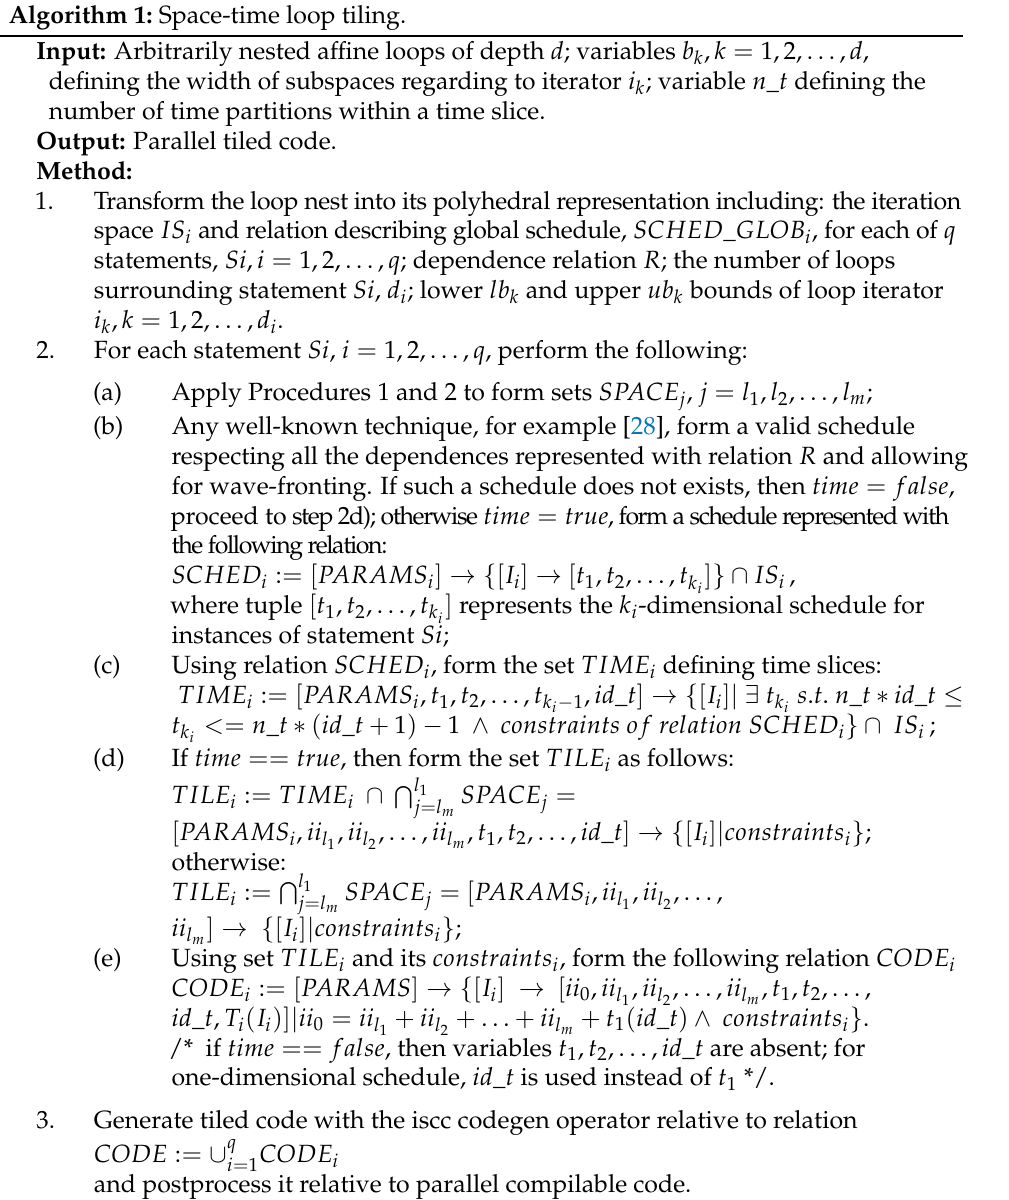
Algorithm 1: Space-time loop